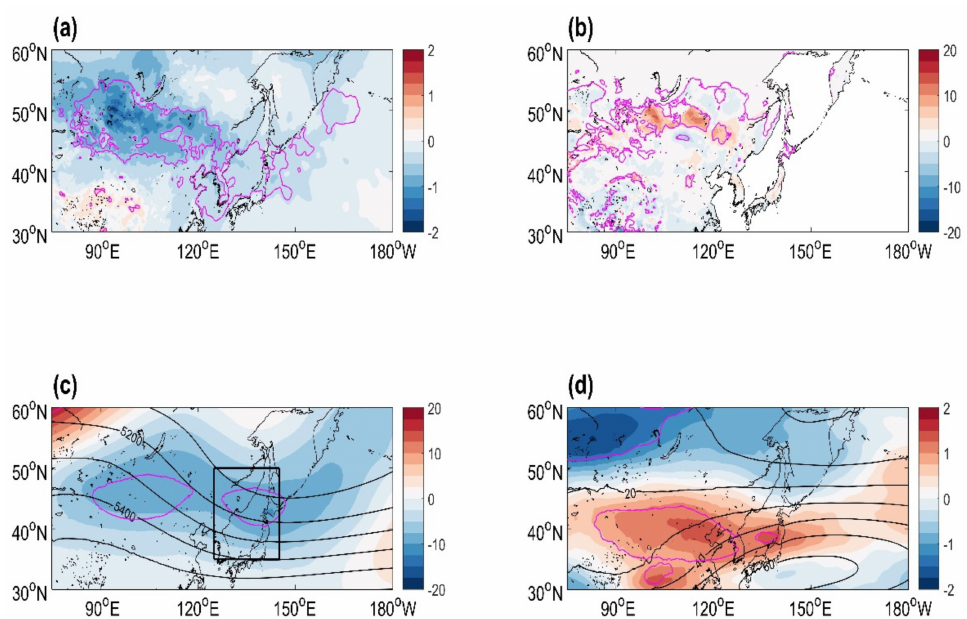
Figure 3. The estimated responses of ( a ) 2 m air temperature (shading, unit: K), ( b ) snow cover (shading, unit: %), ( c ) z 500 (shading, unit: gpm), and ( d ) u 300 (shading, unit: m s − 1 ) in DJF onto the KEI 2 months earlier. The thin black contours and thick black rectangle in ( c ) represent the climatological z 500 in DJF and the area used for calculating the EATII, respectively. The climatological u 300 in DJF is denoted by the black contours in ( d ). Magenta contours represent where the atmospheric anomalies are significant at the 90% confidence level.